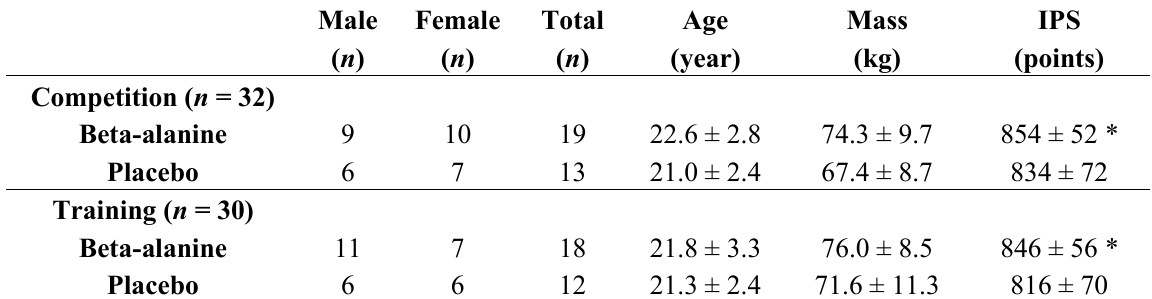
Table 1. Characteristics of swimmers included in the final data analysis. Male Total Mass (kg)